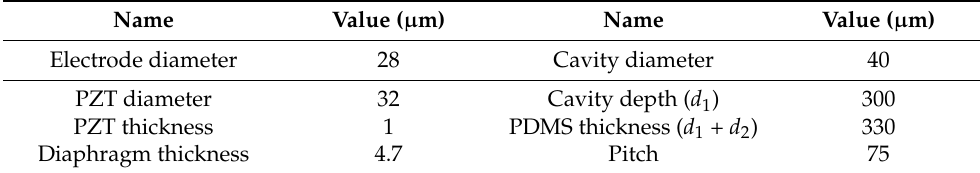
Table 1. The structure parameters.